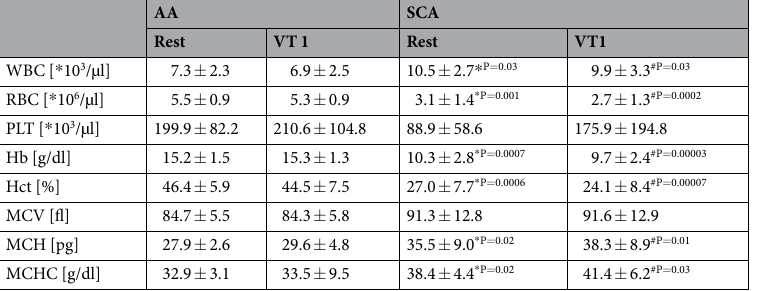
Table 1. Blood parameters in healthy controls (AA, n = 8) and sickle cell anaemia patients (SCA, n = 8) measured at rest and at VT 1. Data are mean ± s.d. * SCA Rest vs AA Rest; # SCA VT1 vs AA VT